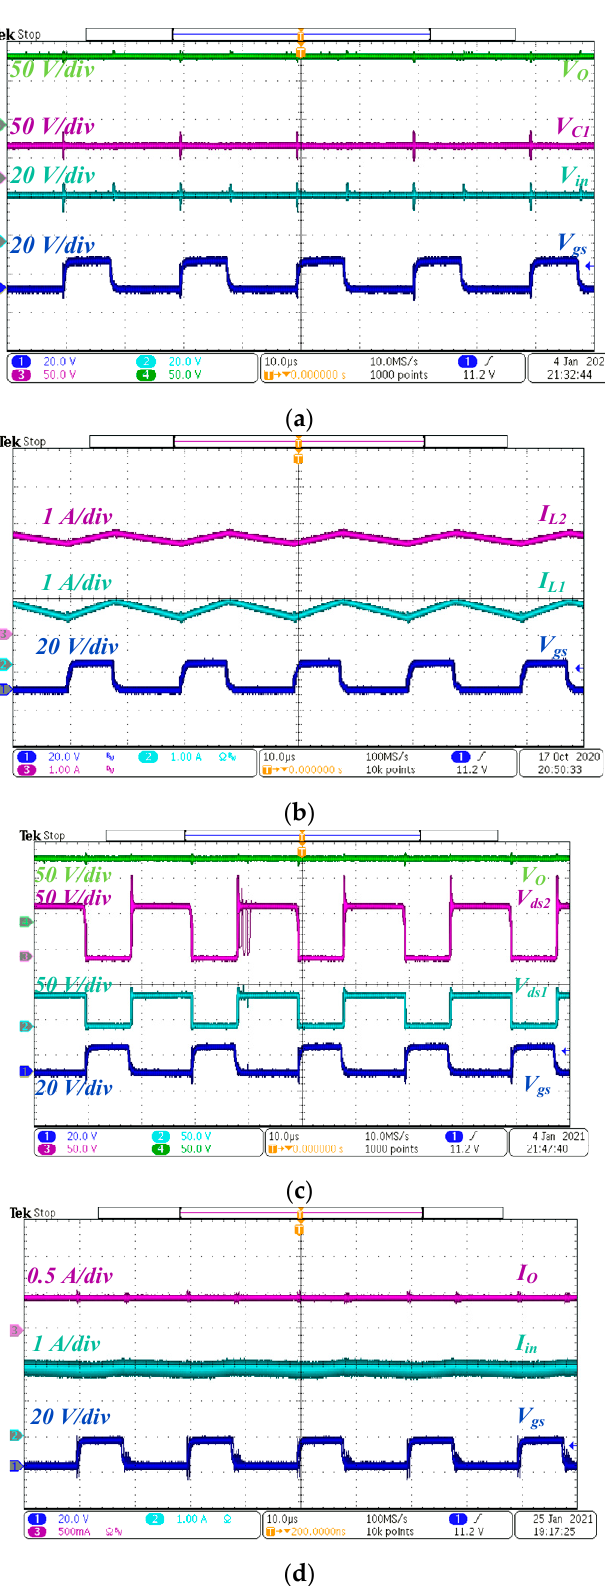
Figure 8. Experimental results at V in = 24 V, D = 0.4. ( a ) V o , V C1 , and V in . ( b ) I L1 and I L2 . ( c ) V o , V ds1 , and V ds2 . ( d ) I o , I in , and V gs. V ds1 , and V ds2 . ( d ) I o , I in , and V gs